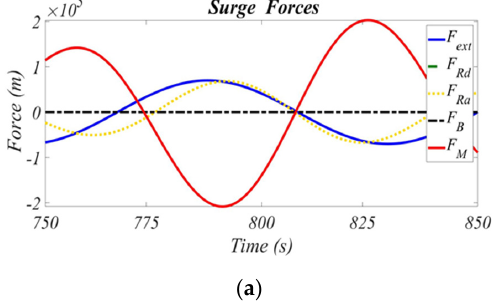
( c ) Figure 16. Time histories of wave-load components at ( a ) the surge natural frequency ( f p = 0.008 Hz), ( b ) the heave natural frequency ( f p = 0.032 Hz), and ( c ) the pitch natural frequency ( f p = 0.037 Hz) for the OC3-Hywind spar. 6.2. UMaine-Hywind Spar Figure 17a–c show the comparisons of RAOs at surge, heave and pitch natural frequencies between hydrodynamic simulator and the experimental data from a 1:30 model implemented in